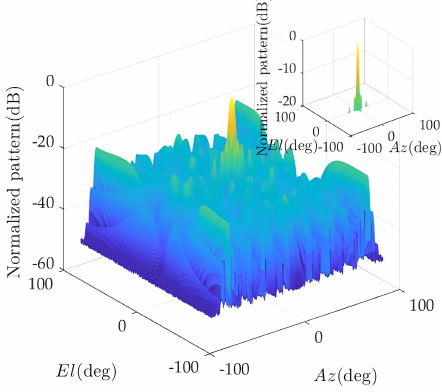
Figure 8. Pattern of the antenna array after optimization.